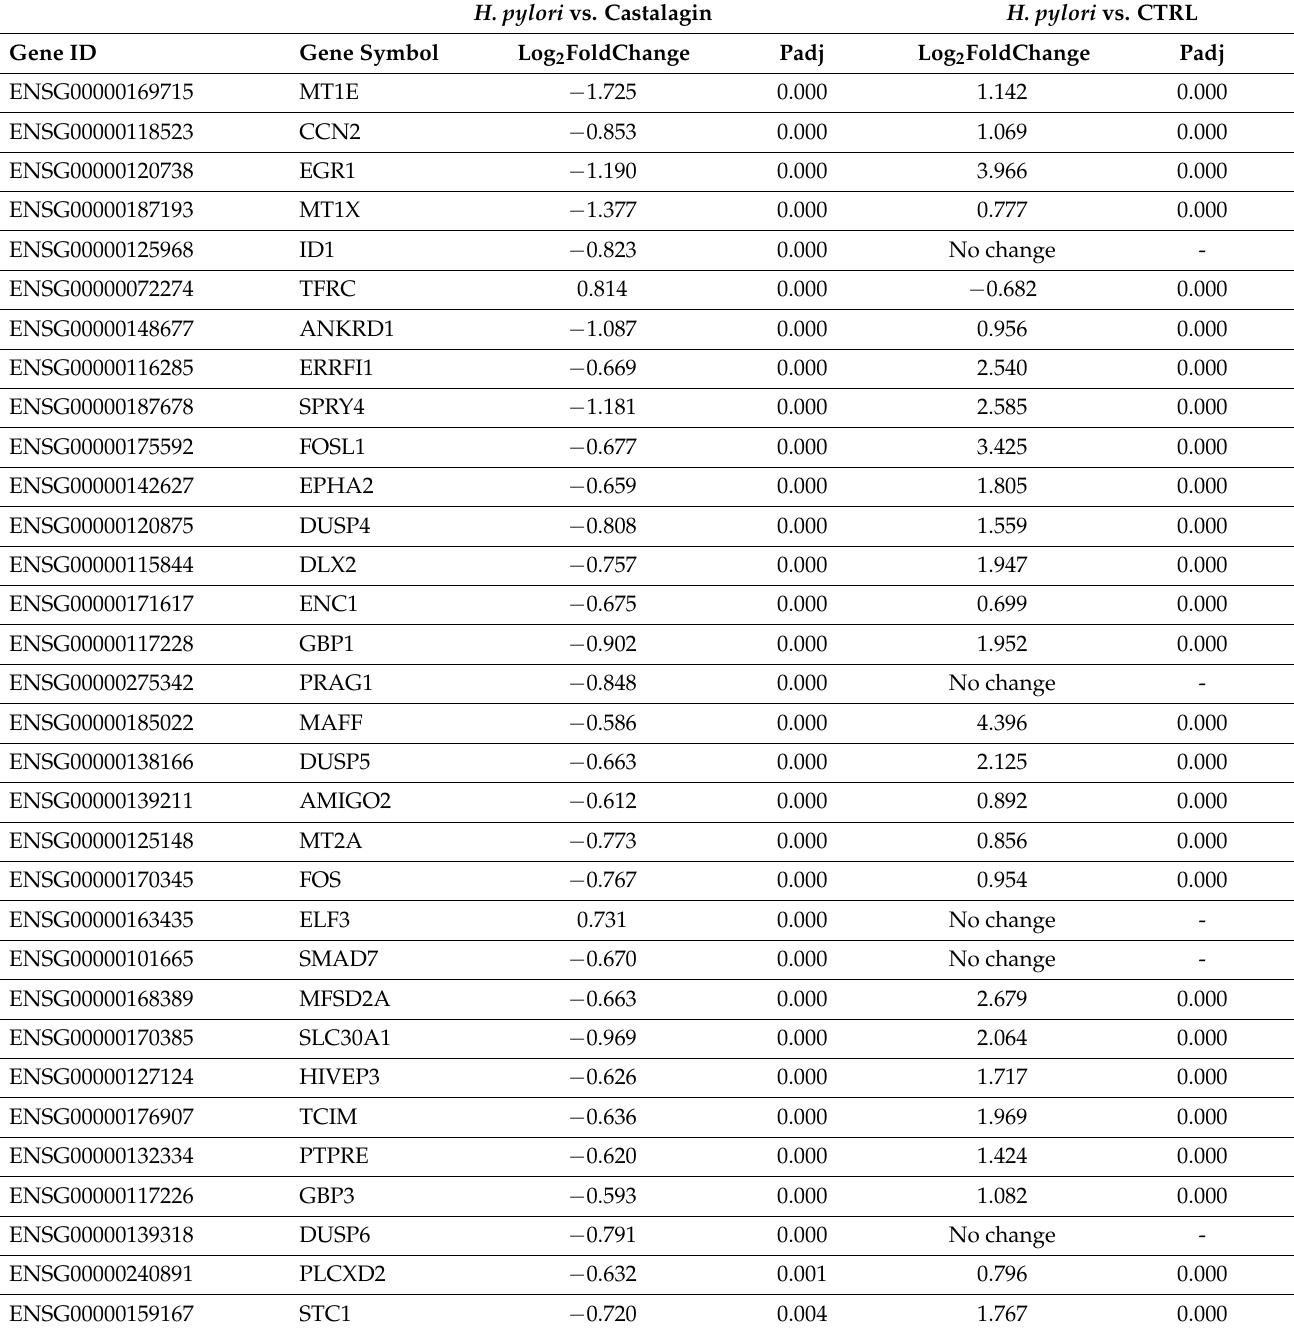
Table 6. Table showing the 36 DEGs from RNA-seq analysis. Genes are reported with both the Ensembl ID and Gene